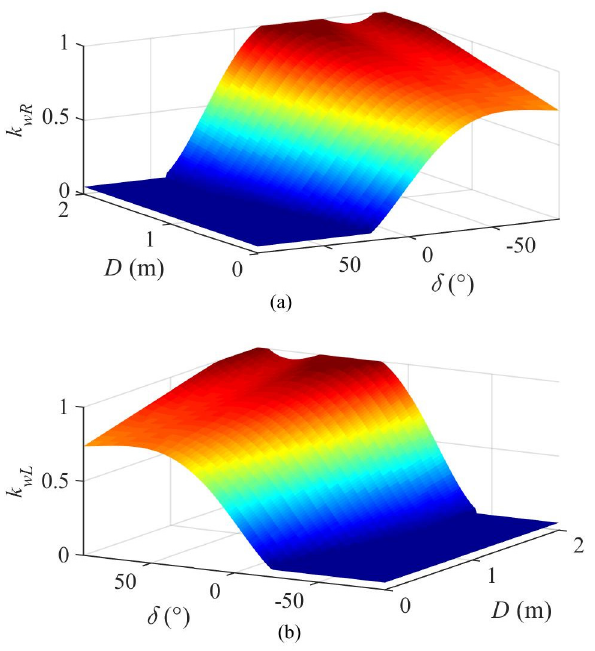
Figure 9. Fuzzy control surfaces of the maximum speed: ( a ) of the right engine; ( b ) of the left engine approximated by means of a polynomial with power m = 1 and n = 5.